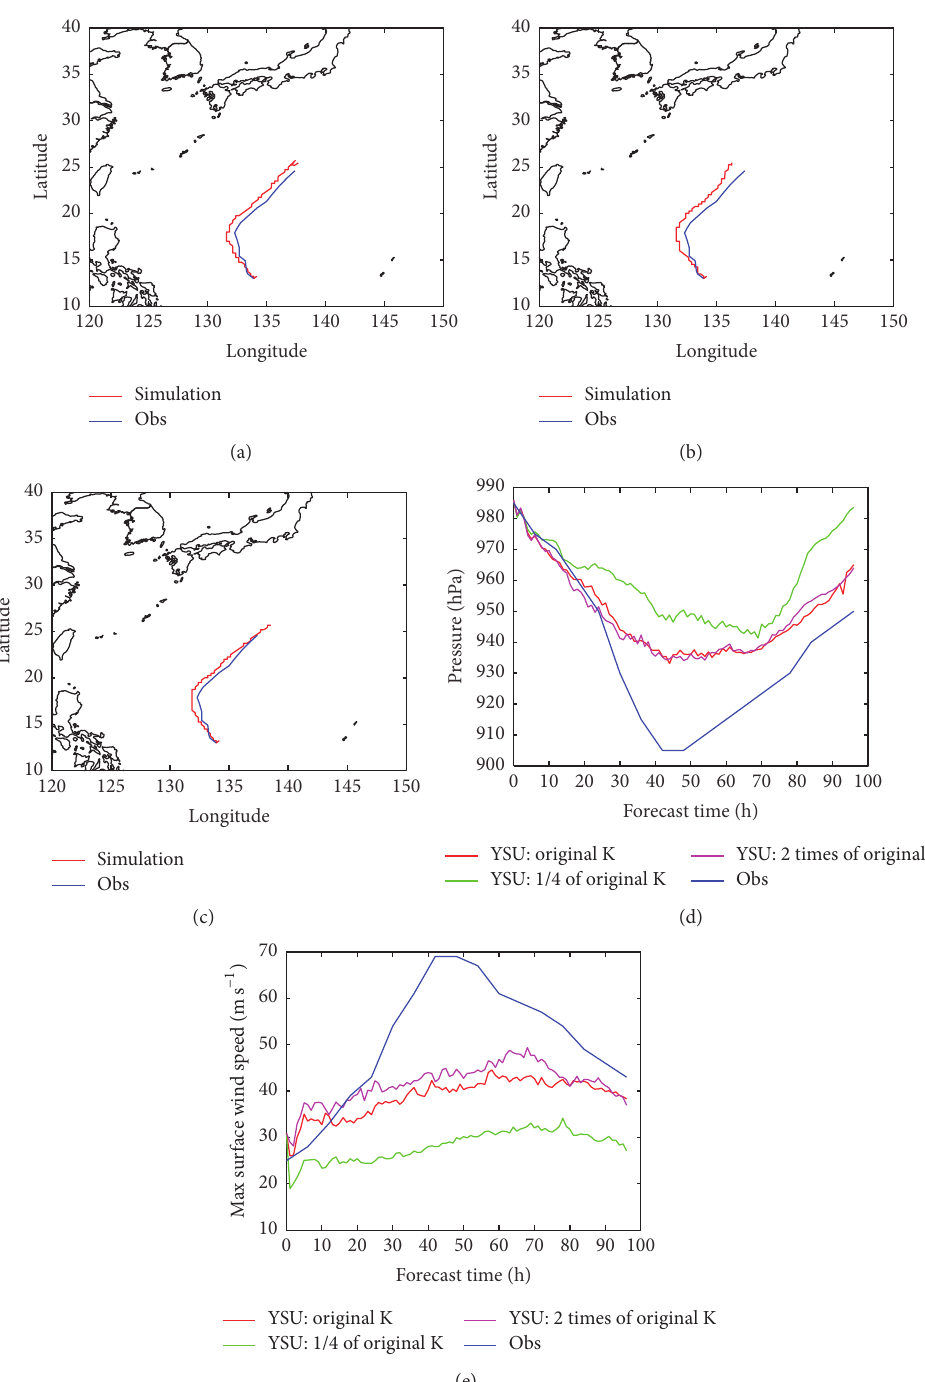
Figure 7: Case 6-Nuri: (a) track simulated by the original YSU; (b) track simulated by the K025; (c) track simulated by the K200; (d) comparisons of center sea-level pressure; and (e) comparisons of maximum surface wind